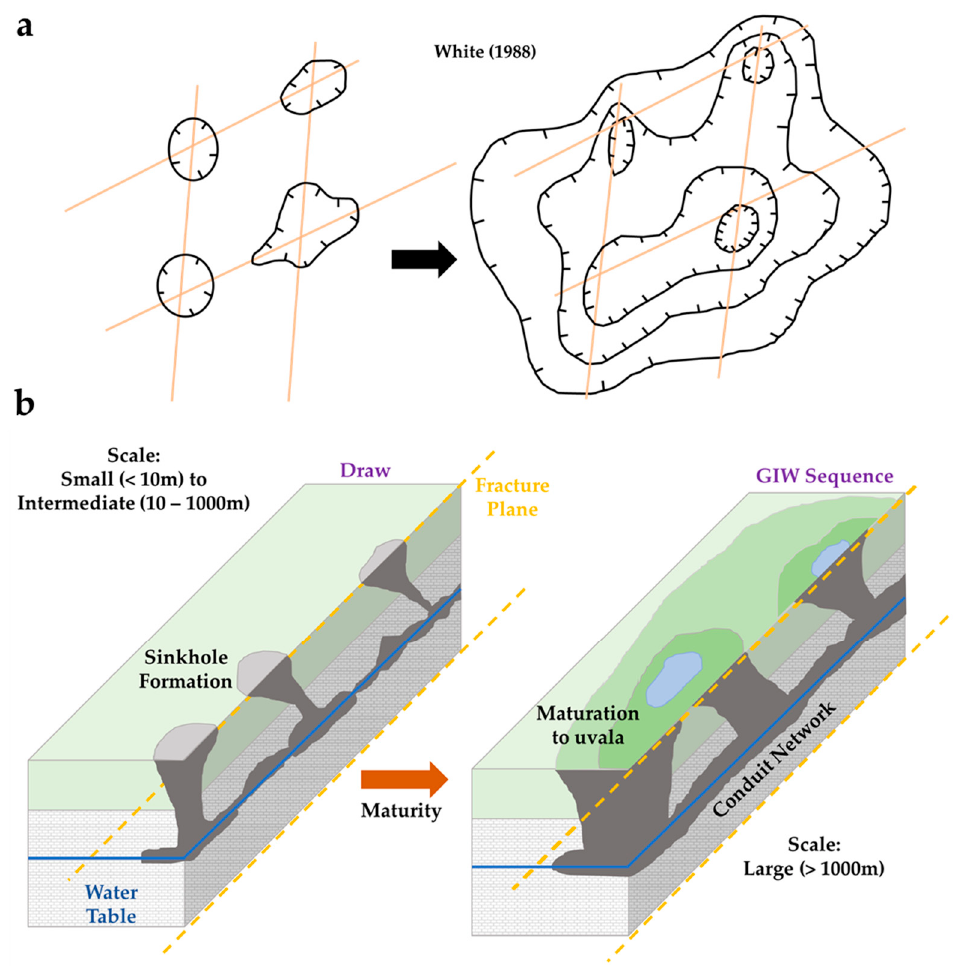
Figure 5. ( a ) The evolution of compound sinkholes ( left ) into a uvala ( right ), through enhanced dissolution along pre-existing fracture planes (orange lines). Modified from White [24]; ( b ) depiction of the small- and intermediate scale (according to Ford [22]) draw connectivity and evolution into the larger GIW sequence as a uvala.